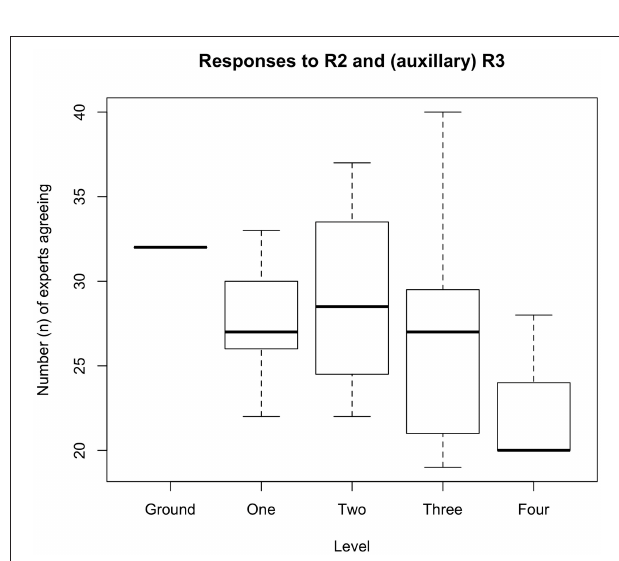
FIGURE 3 | Degree of consensus reached by selected experts ( n = 42), on topics of wolf x dog hybridization. Bold lines represent the median, boxes represent the upper and lower quartile range, and the whiskers represent the maximum and minimum value of outliers. As Level increases, the questions addressed to the experts discuss increasingly practical issues (see Figure 2 ). Question level has a significant effect on consensus (PERMANOVA, p = 0.05), which wanes as question level